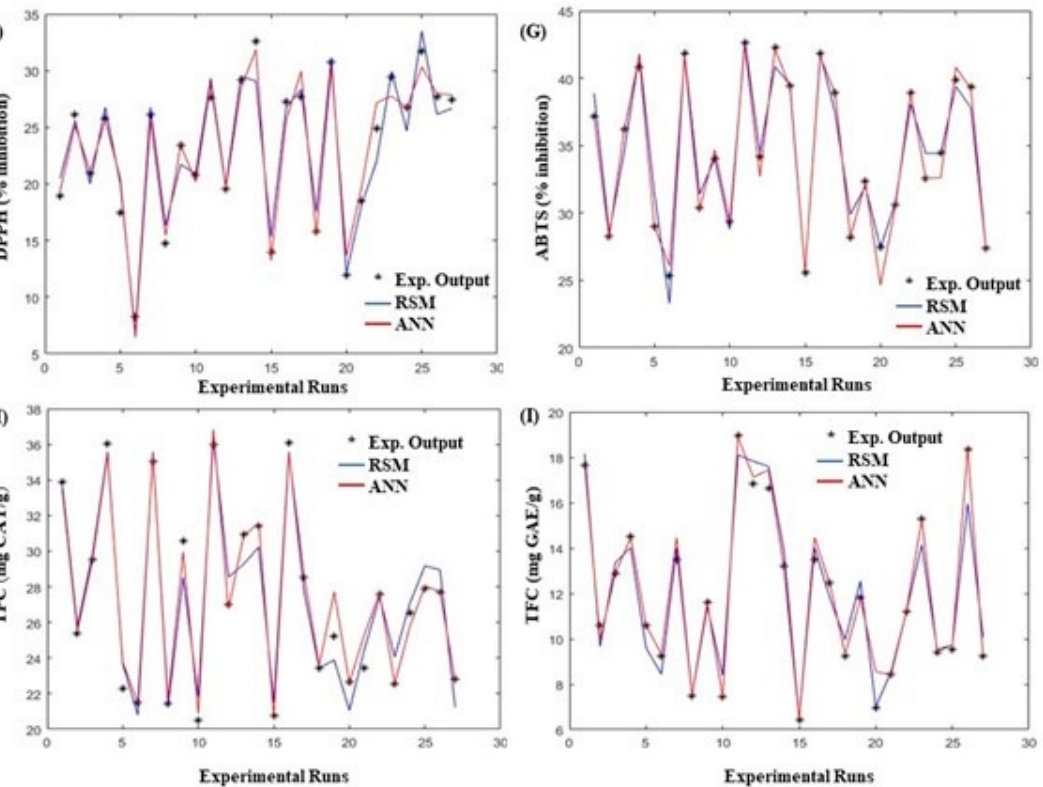
Figure 1. Optimal topology of optimized MAE-assisted SF extracts. Best architecture of a developed MAE-ANN model with the lowest mean square error (MSE) ( A ); The results of Levenberg-Marquardt algorithm with optimum numbers of neurons for best validation performance compared with training, testing and validation data for dependent variables DPPH ( B ) ABTS ( C ), TPC ( D ), and TFC ( E ), and comparison among experiment run (*), RSM (blue line), and ANN (red line) for DPPH ( F ), ABTS ( G ), TPC ( H ), and TFC ( I ) using deep learning toolbox MATLAB software.